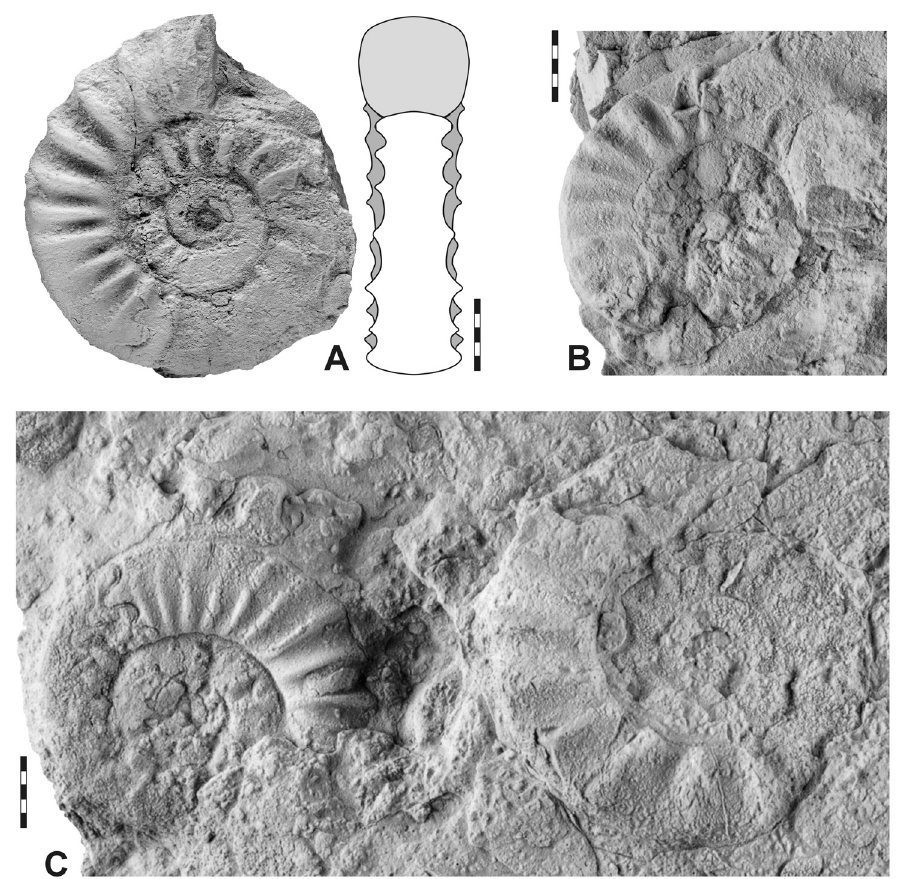
Fig. 20. Arasella minuta (Zakharov, 1983). A . Lateral and dorsal view, specimen MB.C.29720, section C, -0.05 m. B . Lateral view, specimen MB.C.29728, section G, -0.05 m. C . Arasella falcata Korn & Hairapetian sp. nov.; right = specimen MB.C.29731; left = paratype MB.C.29737, section C, -0.05 m. Scale bar units = 1 mm.